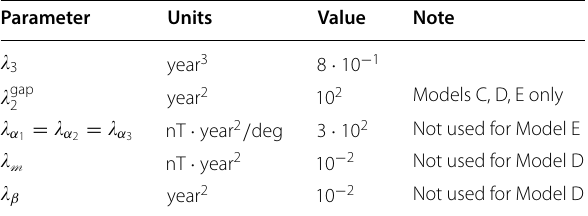
Table 2 Regularization parameters used for geomagnetic field